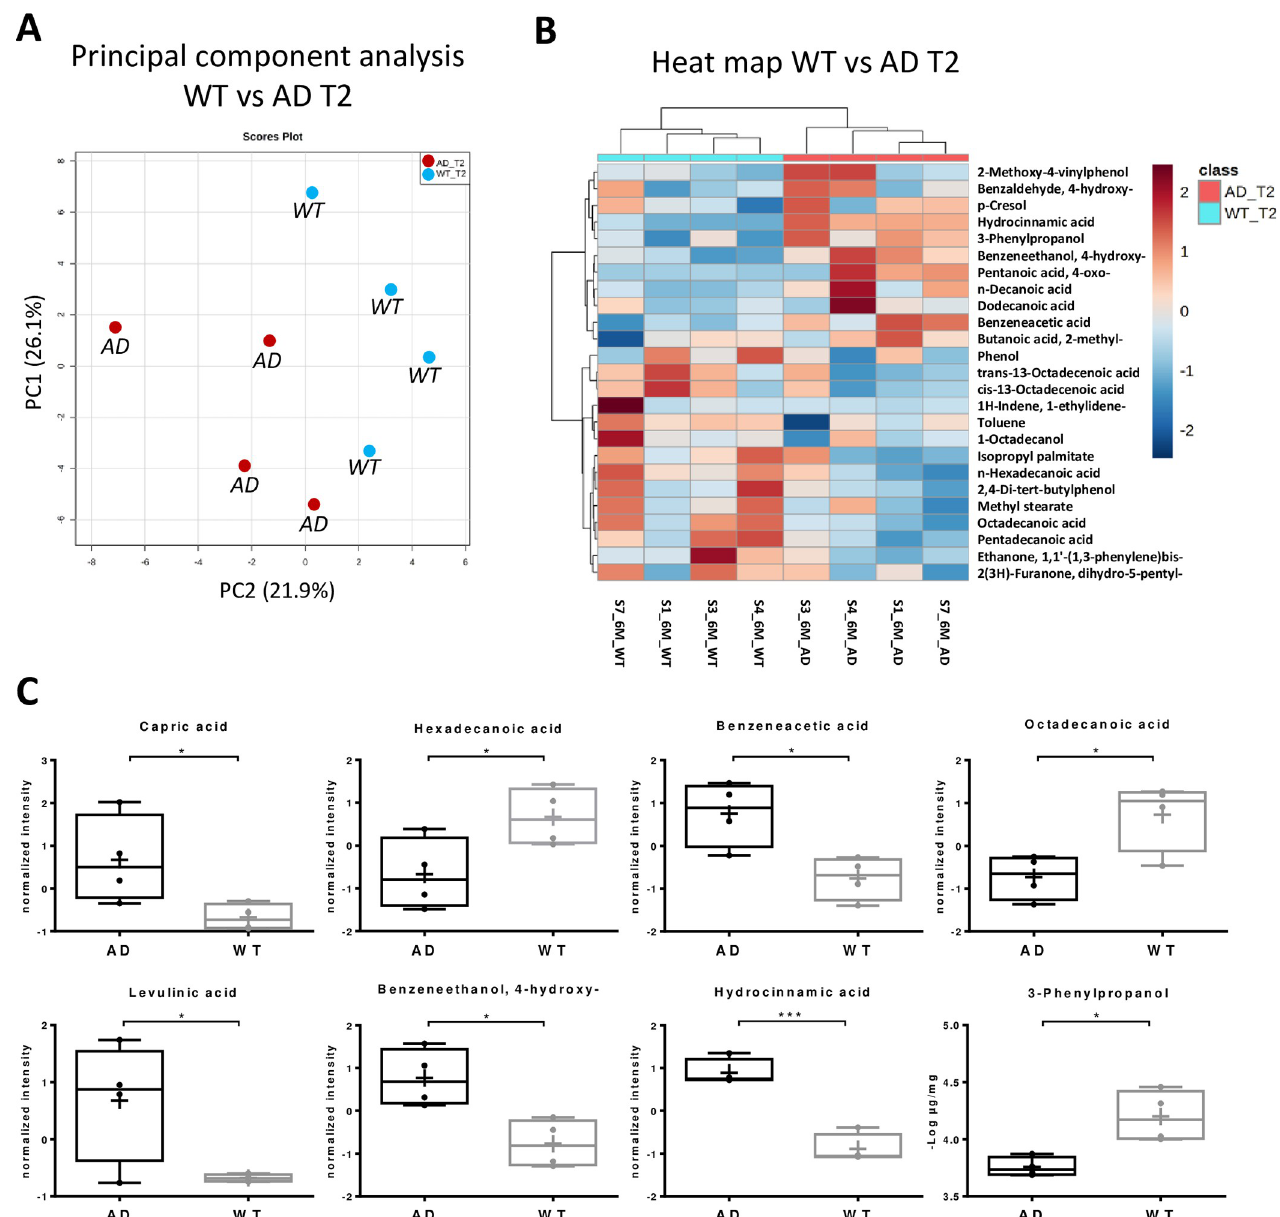
Fig 3. Metabolic profile at six months in AD mouse. A) Score plot of principal component analysis (PCA) showing two distinct groups, the WT (light blue) and the AD mouse model (red). B) Hierarchical clustering heat-map of the most modulated metabolites, C) box plot of modulated molecules at six months (T2), expressed as ‘normalized intensity’, corresponding to normalized abundance of the molecules reported in the heatmap (panel B). � p < 0.05; �� p < 0.01; ��� p < 0.001.